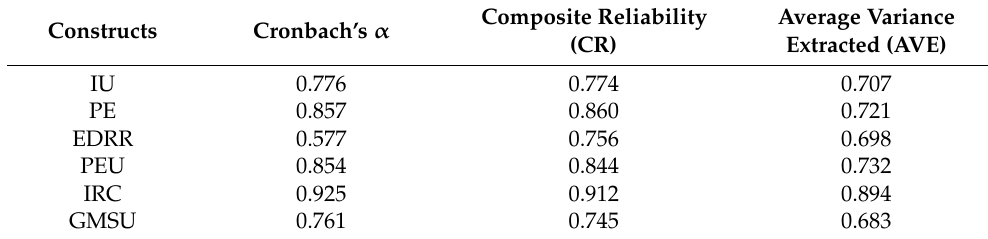
Table 3. Indicators of reliability and